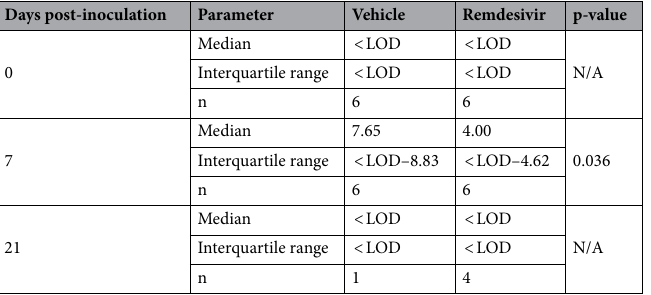
Table 2. Serum viremia (log 10 pfu/mL). LLOQ lower limit of quantitation (4.00 log 10 pfu/mL), LOD limit of detection (0 pfu/mL), N/A not applicable.